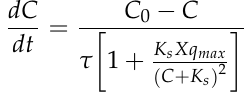
Figure 9. Permeation curves with 4 g/L chitin without and with buffer diafiltration (initial feed concentration of Co was 20 mg/L and pH = 4).